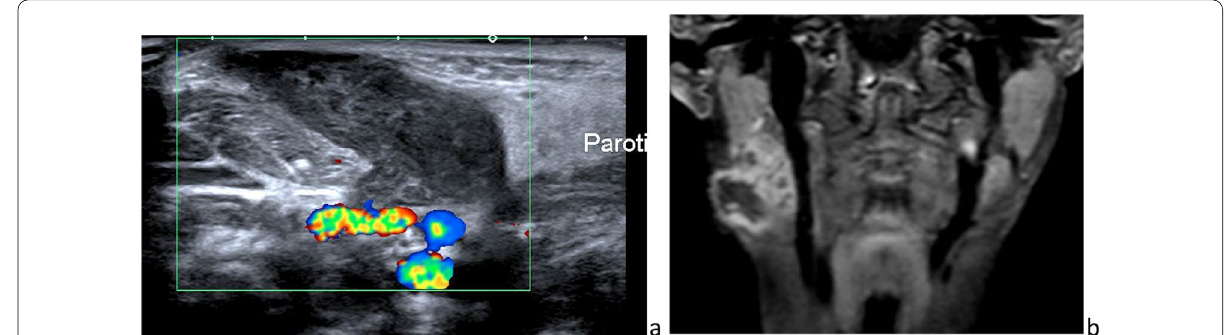
Fig. 7 Mycobacterial infection. Necrotic lymphadenitis located immediately below the parotid gland and complicated by a skin fistula: sonography ( a ) and frontal T 1 ‑weighted image, after intravenous administration of gadolinium chelate ( b